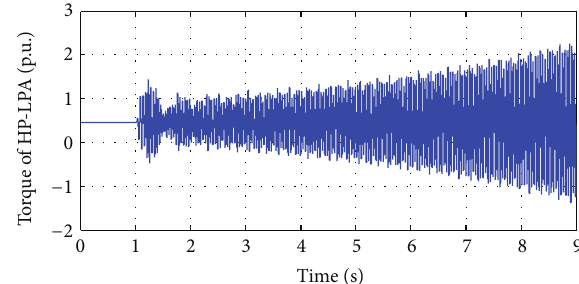
Figure 7: The torque of the generator shaft without SVC.